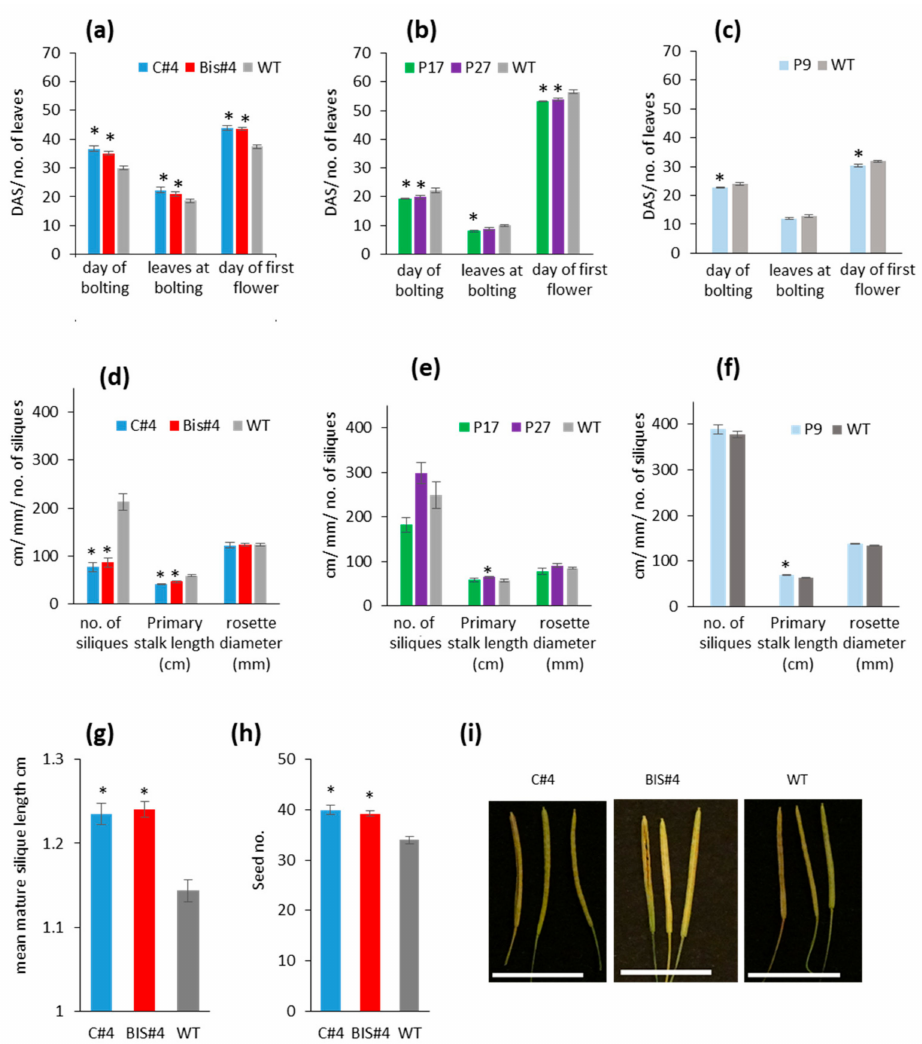
Figure 2. Perturbation of AtCuAO δ expression a ff ects flowering time, stalk height, silique number, and their length: day of bolting and flowering and number of leaves at bolting in ( a ) mutants C#4 and BIS#4 (n = 8); ( b ) over-expressor lines P17 and P27; ( c ) line P9 (n = 8). Also shown are the primary stalk length, number of siliques, and rosette diameter after 8 weeks growth of ( d ) two mutants C#4 and BIS#4 (n = 8); ( e ) over-expressor lines P17 and P27; ( f ) line P9 (n = 8); ( g ) mean mature silique length (n = 100); ( h ) seed number per silique (n = 100 siliques); and ( i ) silique images (scale bar = 1cm) of the two mutants C#4 and BIS#4 siliques; means ± SE, significant di ff erences are indicated by * at p ≤ 0.05 based on a Student t -test where data were normally distributed or Mann-Whitney test where data were